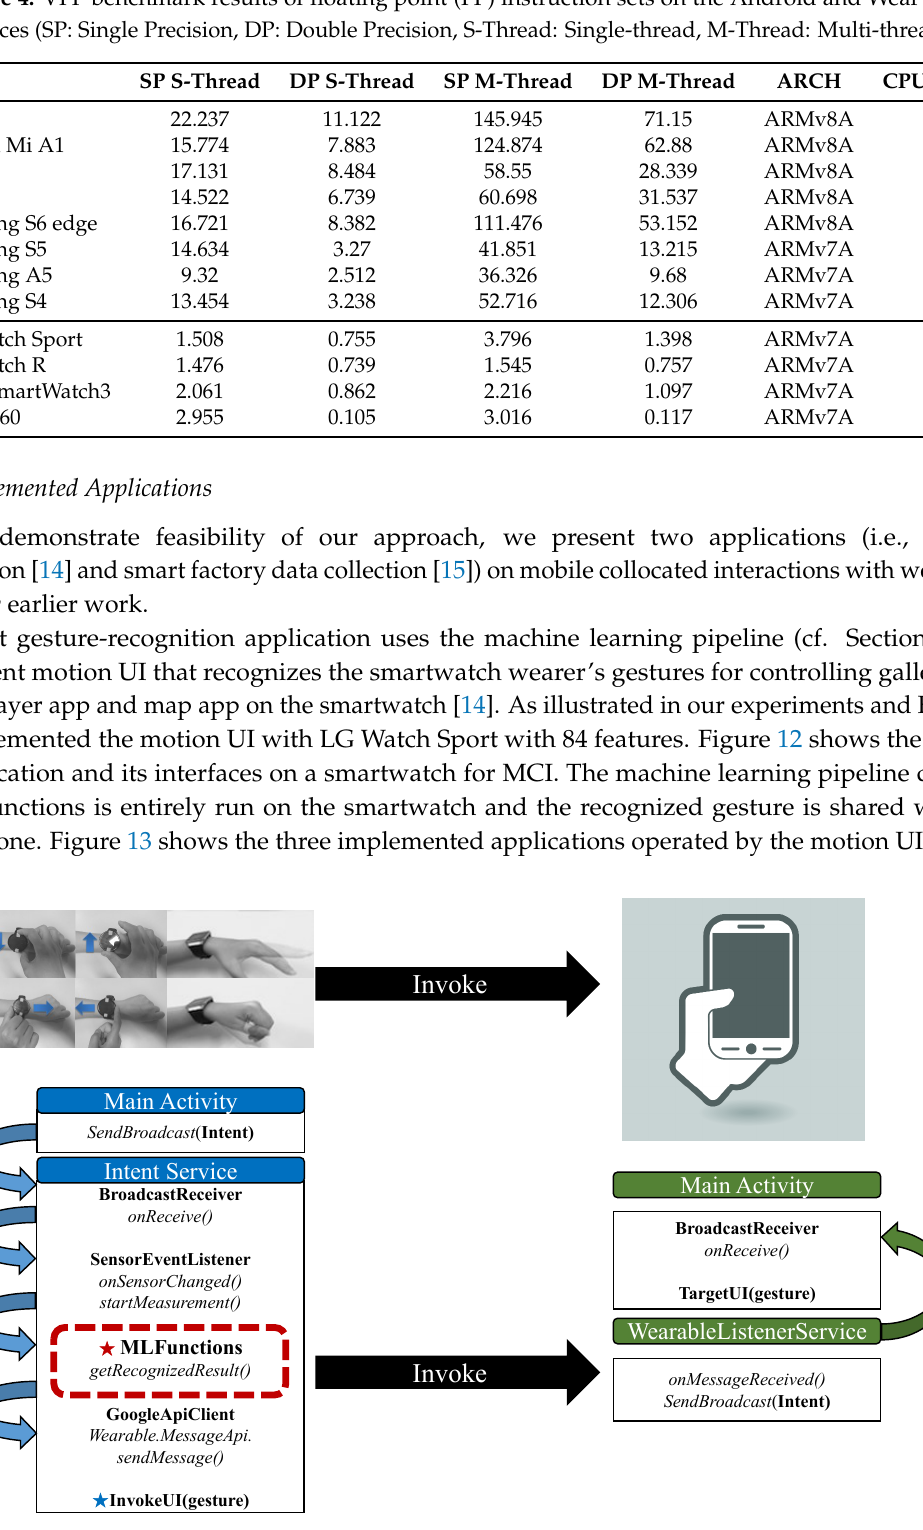
Table 4. VFP benchmark results of floating point (FP) instruction sets on the Android and Wear OS